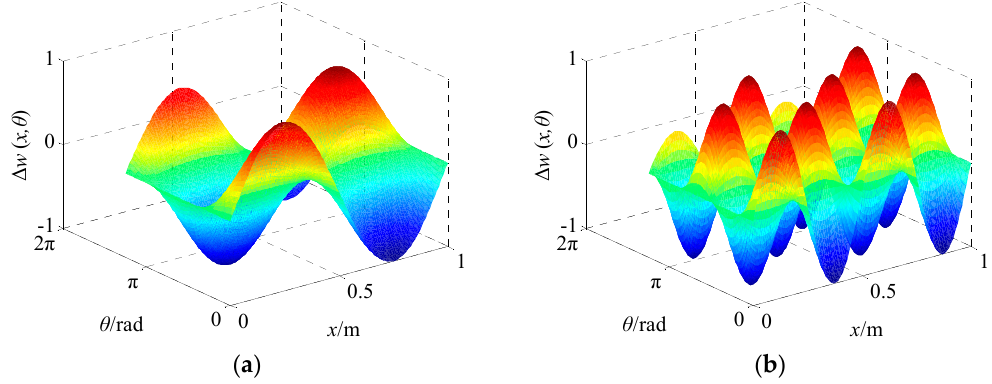
Figure 5. Displacement modes of the UUV body structure with ( a ) B(2,1); ( b ) B(4,2).